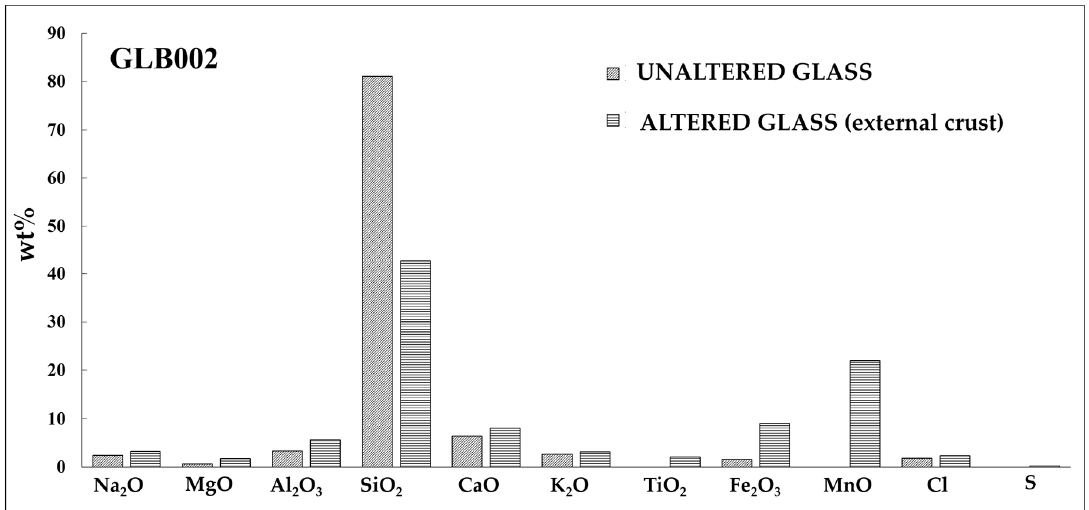
Figure 4. SEM images acquired on the dark-brown area of sample GLB002 .